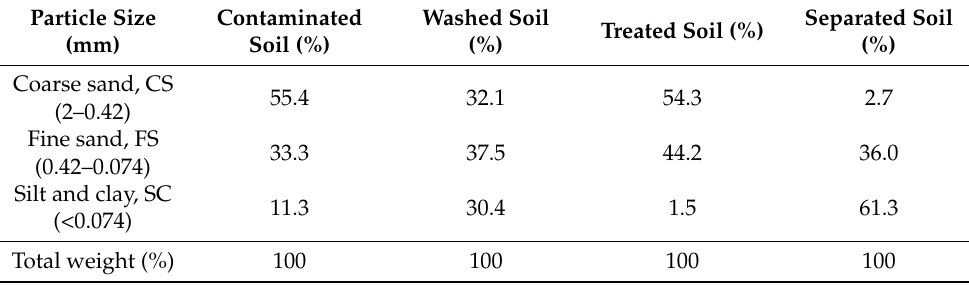
Table 2. Change in soil particle size fractions during the washing process.